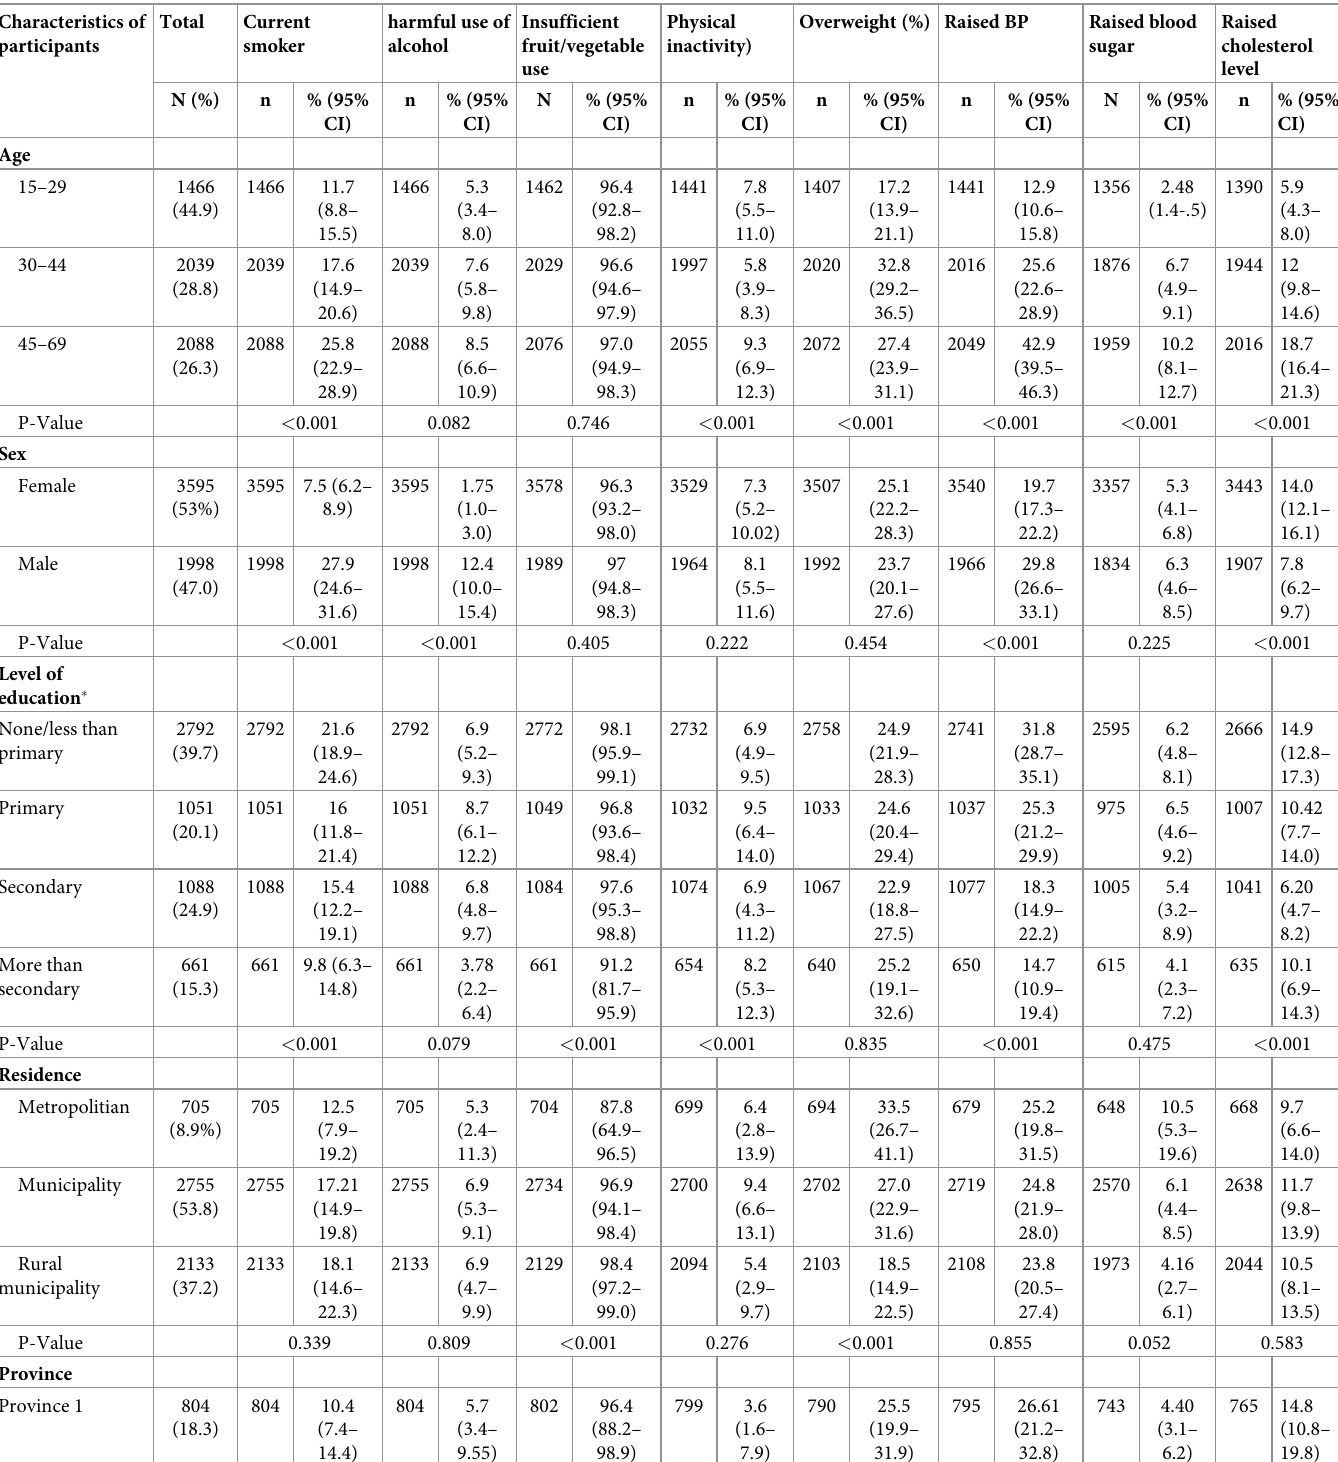
Table 2. Prevalence of NCD risk factors among socio-demographic characteristics. Characteristics of